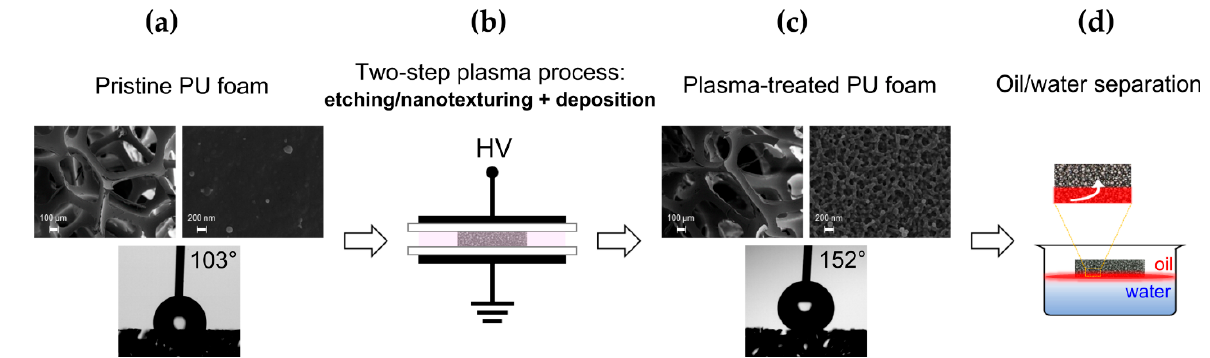
Figure 1. Overview of the present study in which an atmospheric pressure plasma process was optimized to prepare a superhydrophobic/superoleophilic PU foam able to selectively remove oils and nonpolar organic solvents from water: ( a ) representative SEM images of the pristine open-cell PU foam and photograph of a water droplet placed on it for WCA measurement; ( b ) surface modification of the foam by a two-step plasma process carried out using a parallel-plate DBD reactor and combining an etching/nanotexturing step and a subsequent deposition step; ( c ) representative SEM images of the plasma-treated PU foam and photograph of a water droplet placed on it for WCA measurement; ( d ) oil/water separation test carried out with the plasma-treated PU foam.